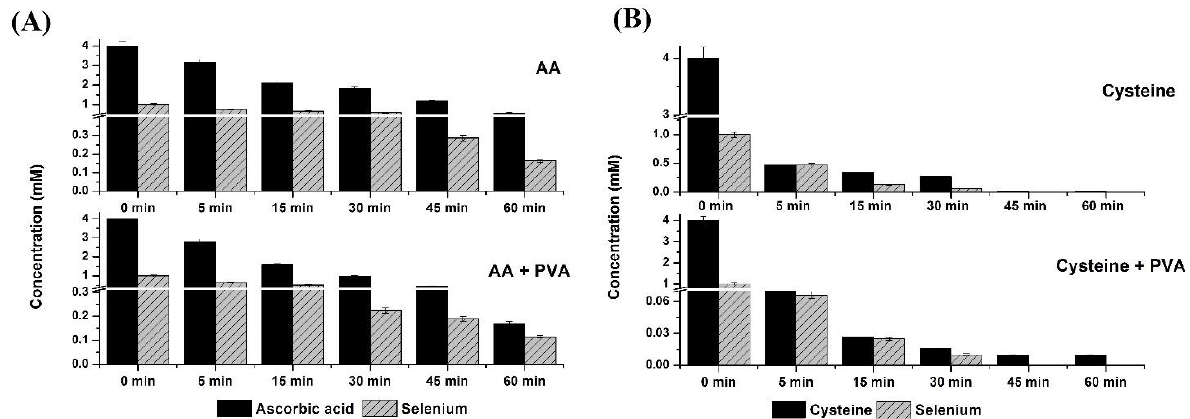
Figure 2. The changes in the concentration of selenium salt and reductants: ( A ) AA and ( B ) Cys as a function of synthesis time.